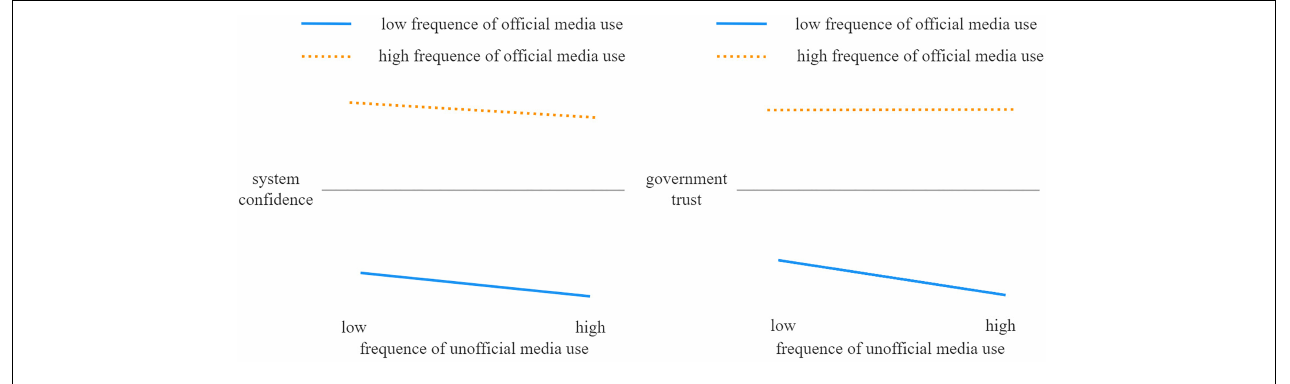
FIGURE 2 | Sketches of the dual moderating effects of official media